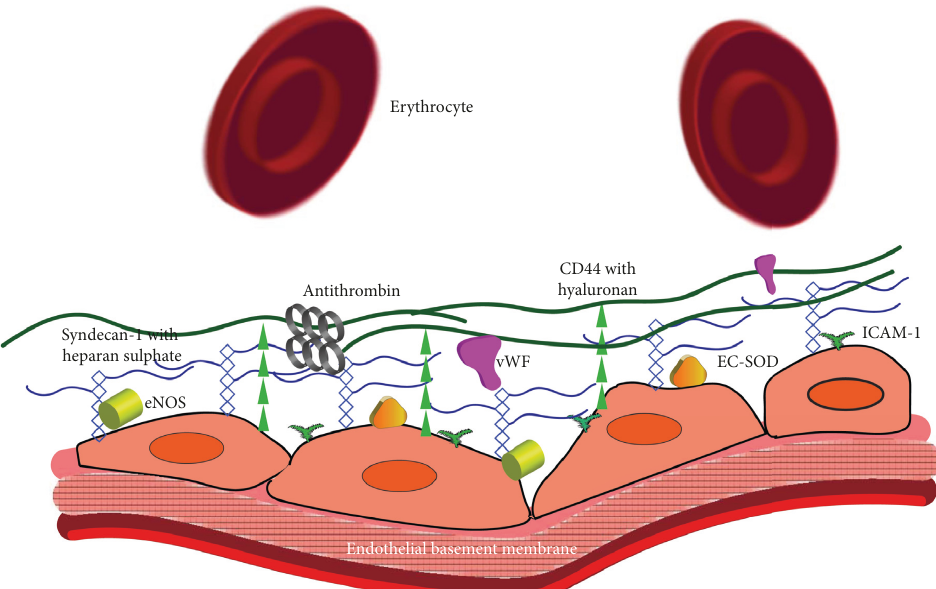
Figure 1: Endothelial glycocalyx: longitudinal cross section of blood vessels with endothelial cells adherent to the endothelial basement membrane. The endothelial glycocalyx is secreted by the underlying endothelial cells and projects 0.5–1.2 μ m into the blood vessel lumen forming a negatively charged meshwork of glycosaminoglycan branches that interact and form a barrier to the overlying albumin, macromolecules, and red blood cells alike. The most numerous components of the glycocalyx are the anchoring proteoglycan syndecan-1 with its attached glycosaminoglycans, namely, heparan sulphate (represented by the blue rectangles and lines) and chondroitin sulphate (not drawn). Another structural component is hyaluronan, which occurs in chains, of several million dalton in size, attached to the underlying endothelium by the glycoprotein CD44 (represented by the green triangles and lines). The glycocalyx interacts with other endothelial structures such as intracellular adhesion molecule-1 (ICAM-1; represented by the green T’s) by acting as a physical barrier and preventing leucocytes from reaching these much shorter glycoprotein adhesion molecules. Shown also are the adherent plasma proteins that interact with the glycocalyx, providing vital endothelial functions such as haemostasis by binding von Willebrand factor (vWF; represented by the magenta objects) and antithrombin (represented by the grey circles). In addition, binding extracellular superoxide dismutase (EC-SOD; represented by the gold triangles) and endothelial nitric oxide synthase (eNOS; represented by the yellowish green cylinders), the glycocalyx contributes to protection from free radical injury and mechanotransduction,